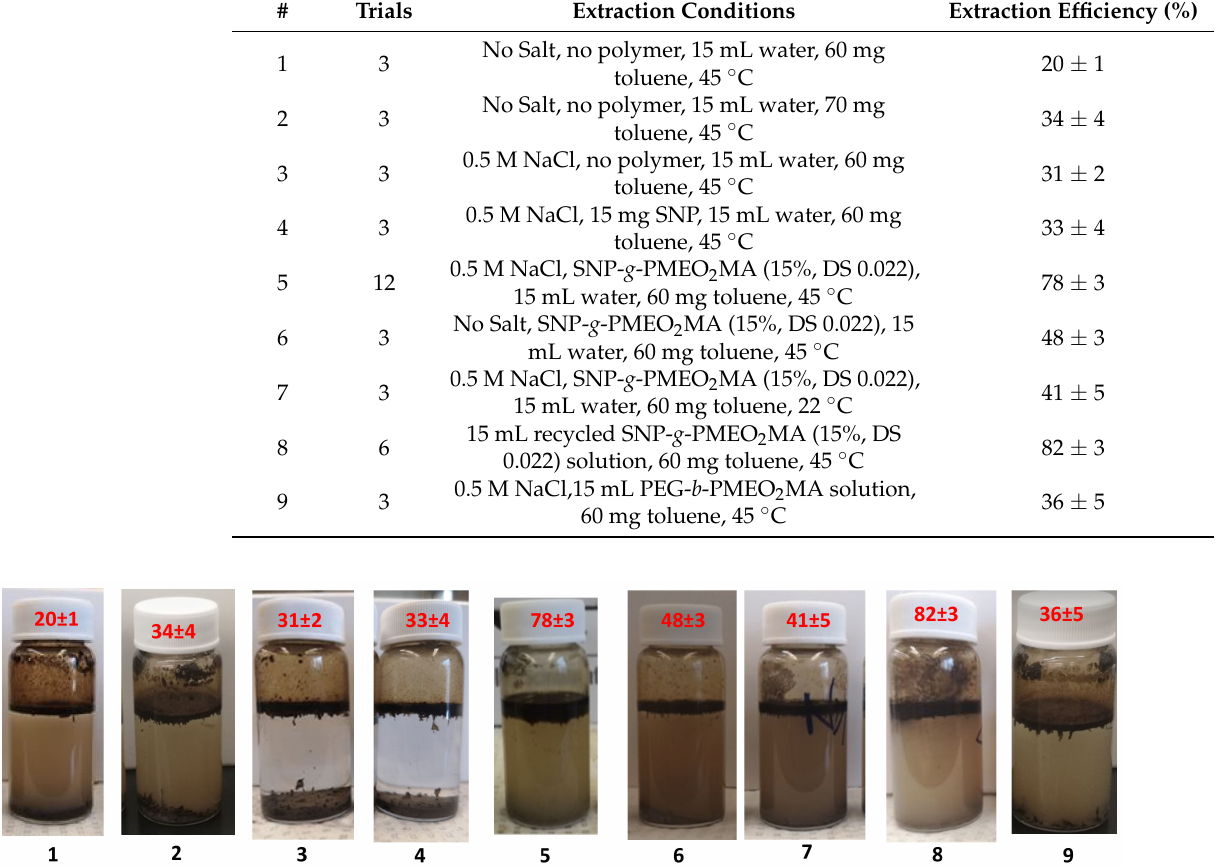
Table 3. Bitumen extraction under different conditions.